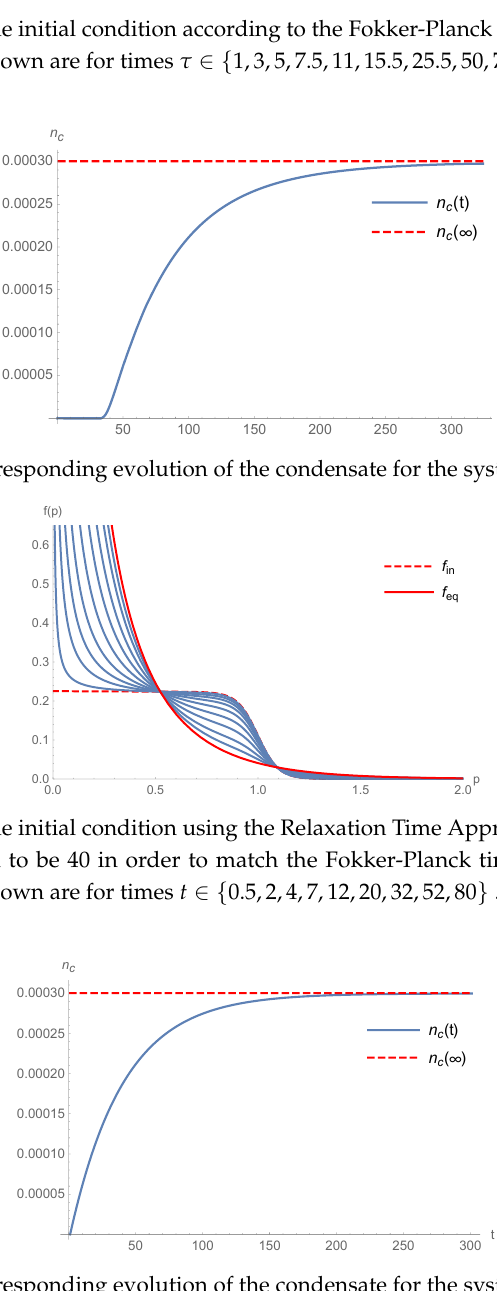
Figure 6. Corresponding evolution of the condensate for the system in Figure